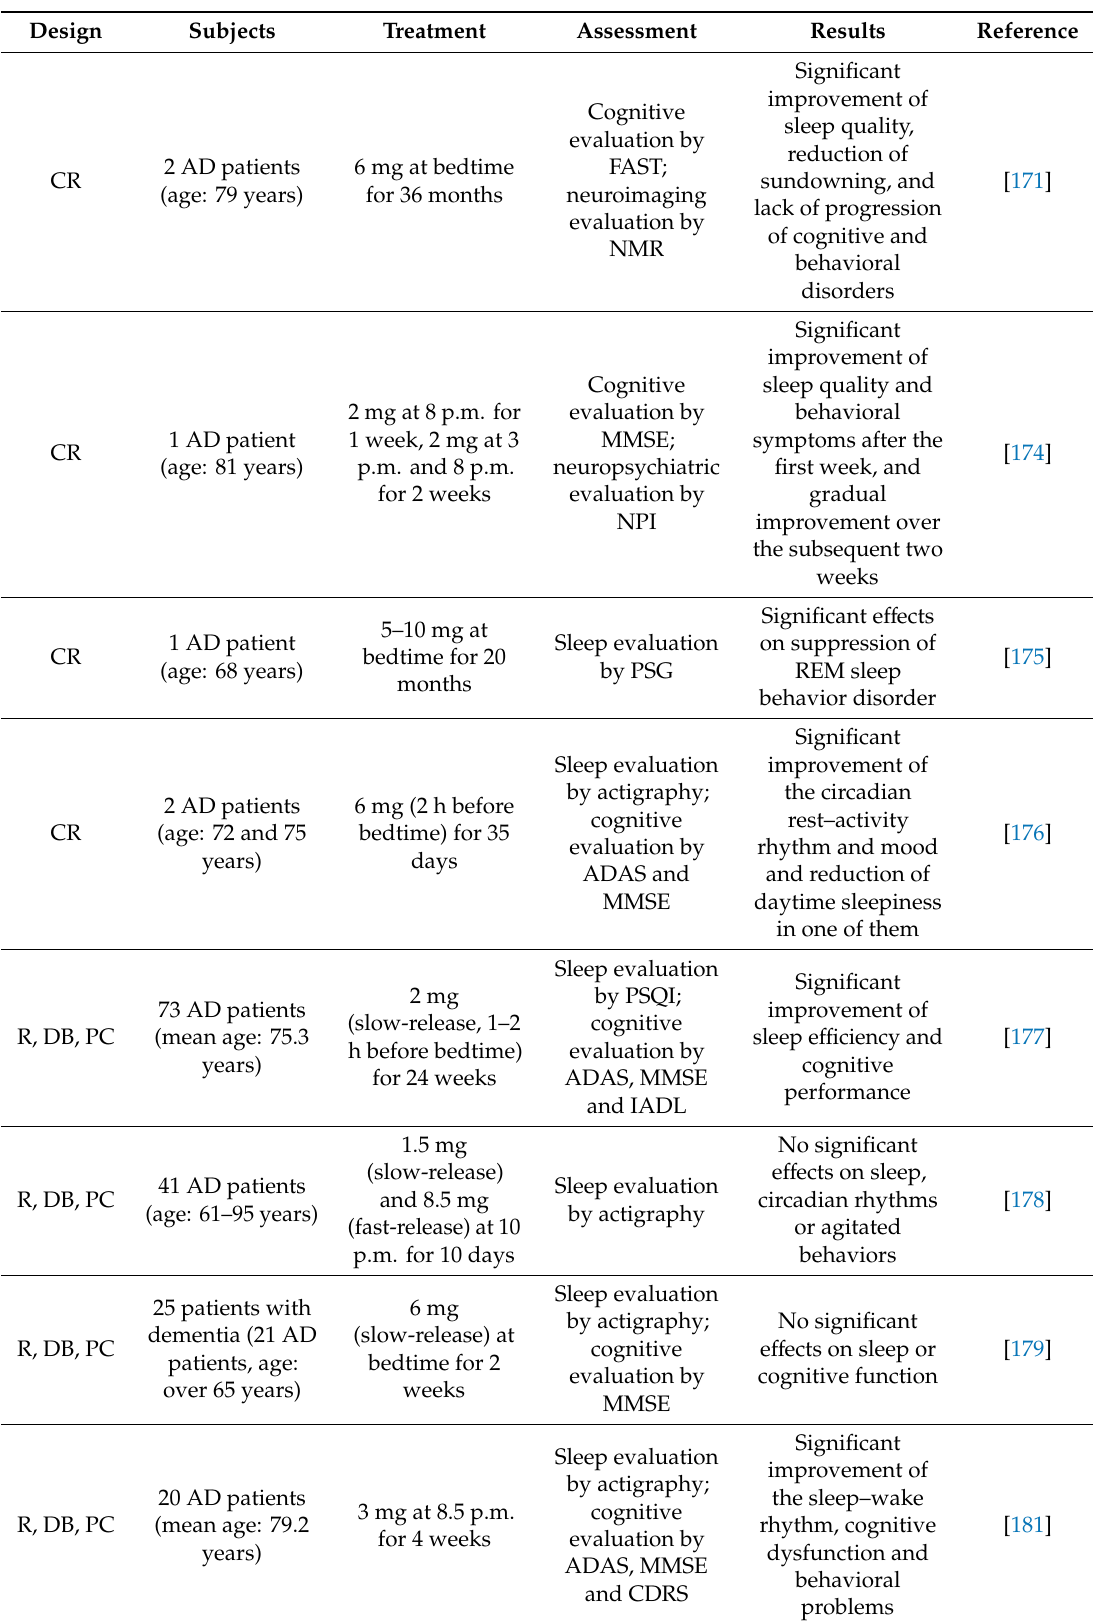
Table 7. Clinical studies including the treatment of AD and PD patients with melatonin.